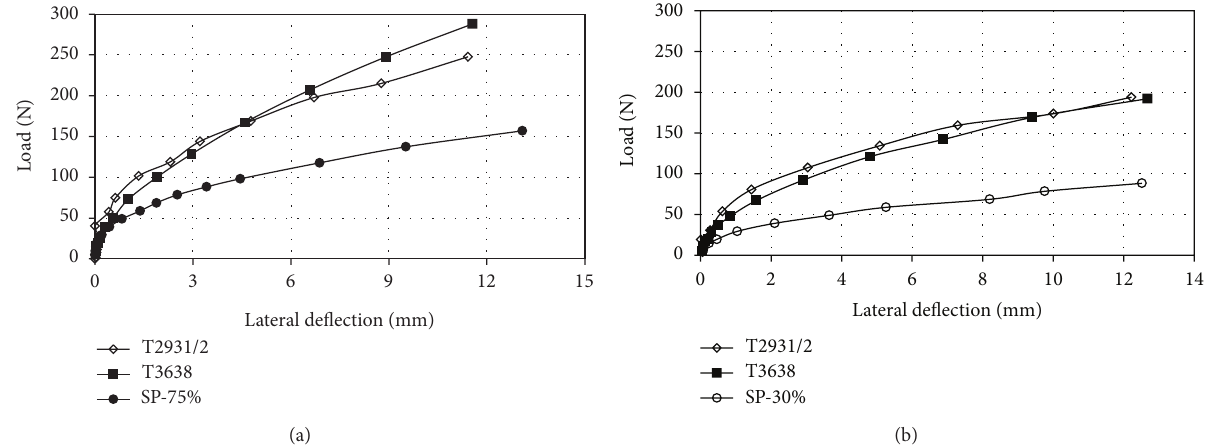
Figure 8: Lateral load versus lateral deflection for three-pile group in series layout; (a) 𝐷 𝑟 =75% and (b) 𝐷 𝑟 =30%.